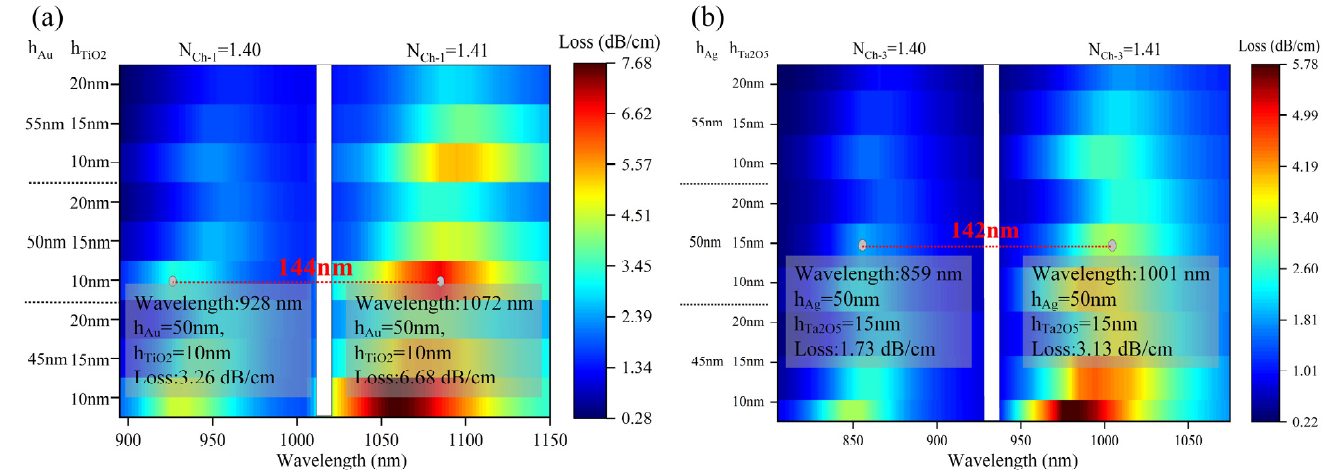
Figure 5. Effect of different thicknesses of materials on sensing performance. ( a ) Thickness analysis of Au layer and TiO 2 layer in Ch-1; ( b ) Thickness analysis of Ag layer and Ta 2 O 5 layer in Ch-3.